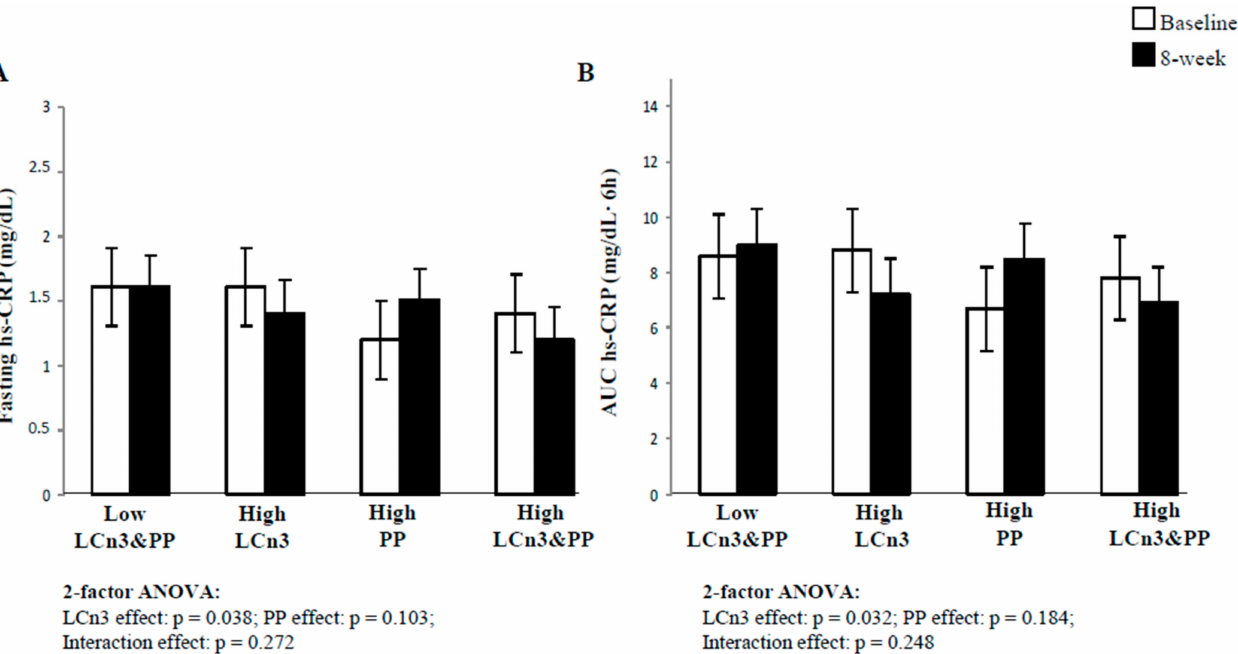
Figure 1. Fasting ( A ) and postprandial ( B ) plasma hs-CRP concentrations at baseline (white square) and after 8-week dietary intervention (black square) in the four experimental groups. Mean ± SEM. Comparisons made by 2-factors ANOVA of percent changes in plasma hs-CRP adjusted for sex, age, and baseline BMI. LCn3, long-chain n-3 fatty acids; PP, polyphenols. n = 14 for Control, n = 18 for High LCn3, n = 17 for High PP, n = 15 for High LCn3&PP